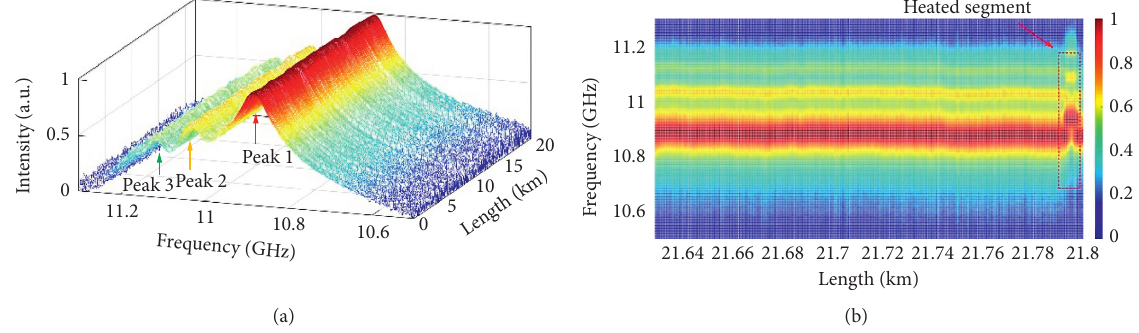
Figure 2: (a) Three-dimensional map of the measured Brillouin gain spectrum as a function of length and (b) measured Brillouin gain spectrum with a heated segment.